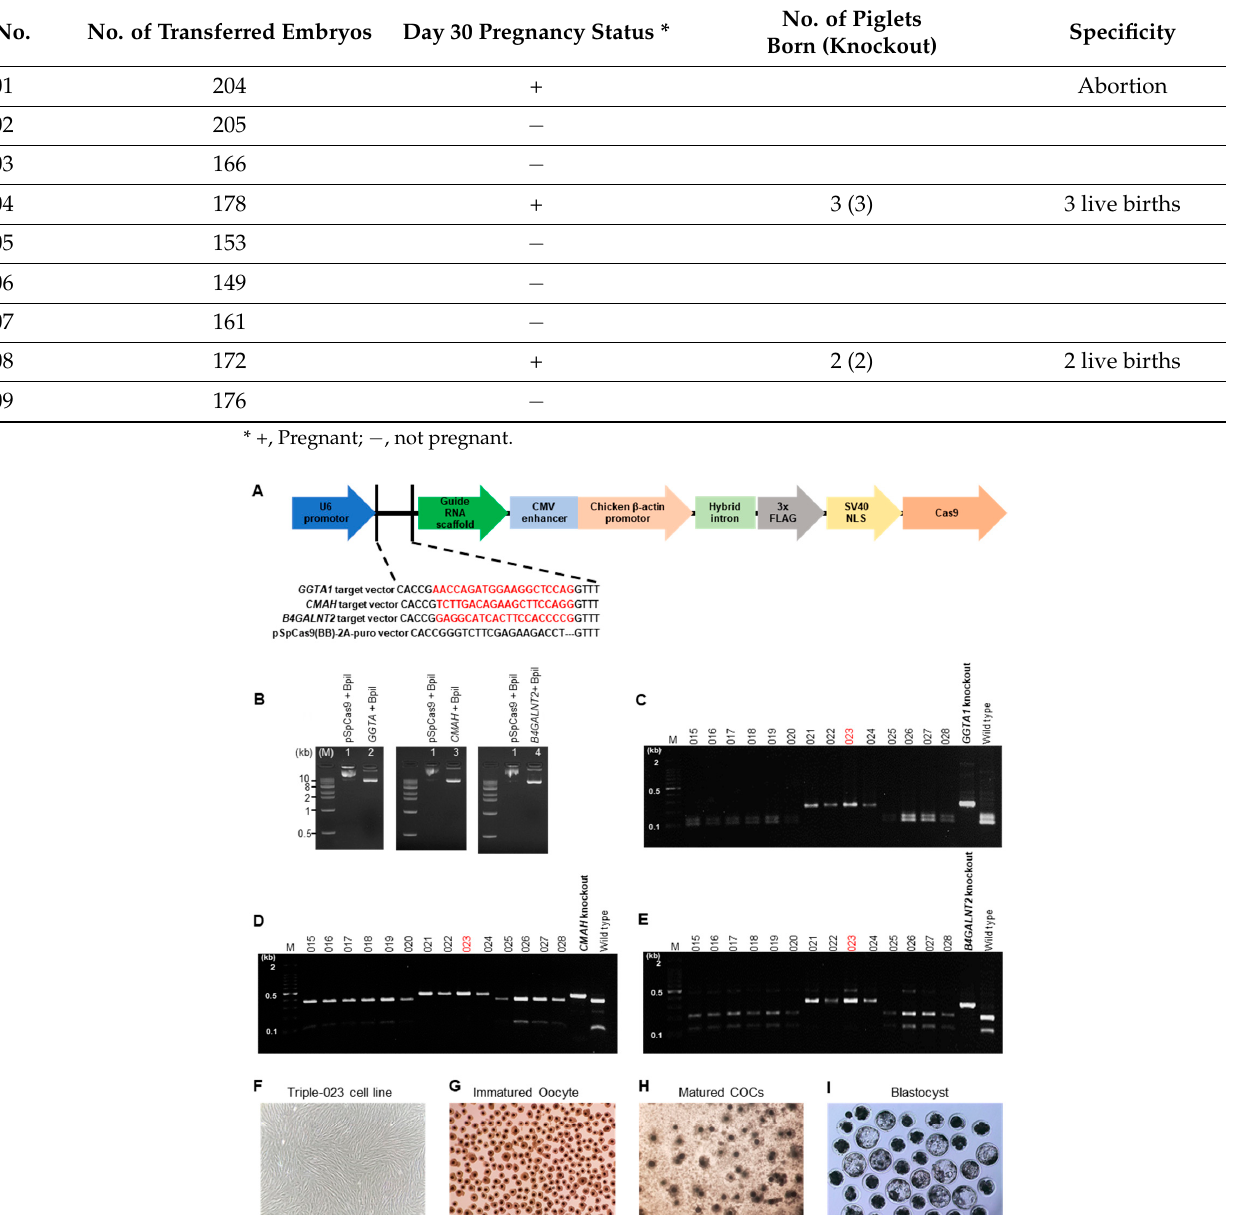
TKO JNPs The structure and cell morphology of each tissue did not differ between the wild ‐ type and TKO JNPs (Figure 3). The distribution of α‐ Gal, Neu5GC, and Sd(a) antigens in the tissues of wild ‐ type and TKO JNPs was analyzed using immunofluorescence. As shown in Figures 4 and 5, the intense expression of the three glycans was confirmed in all the tissues of wild ‐ type JNPs, but the intensity of expression was different in each tissue. In the kidney tissue of wild ‐ type JNPs, α‐ Gal and Neu5Gc were sporadically distributed,